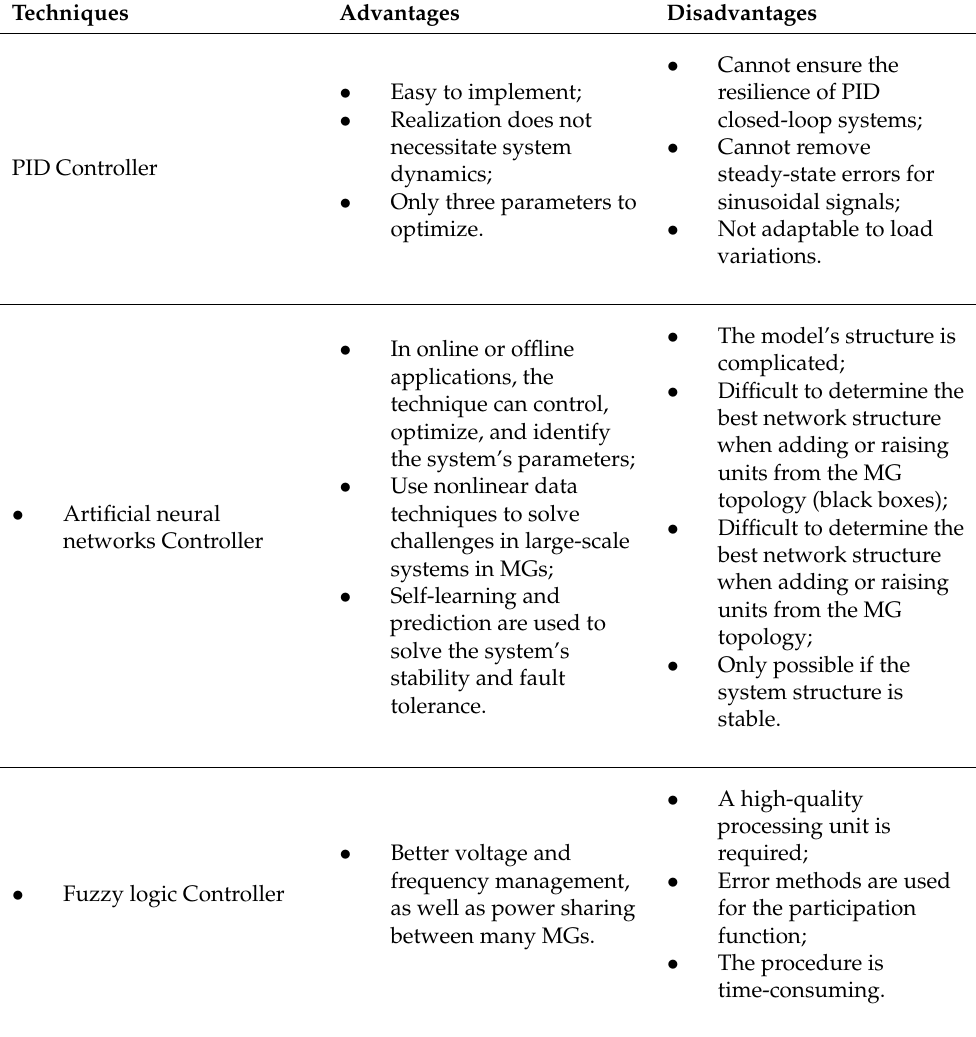
Table 1. Brief comparison of control